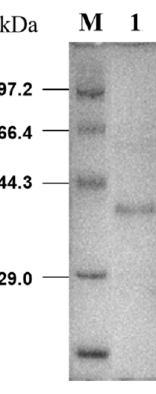
Figure 4. SDS-PAGE of the purified collagenase expressed by B. subtilis WB600/pP43NMK- col. M, molecular weight markers; lane 1, purified collagenase. Table 1. Specific activity of the enzyme at different concentrations of ammonium sulfate precipitation.